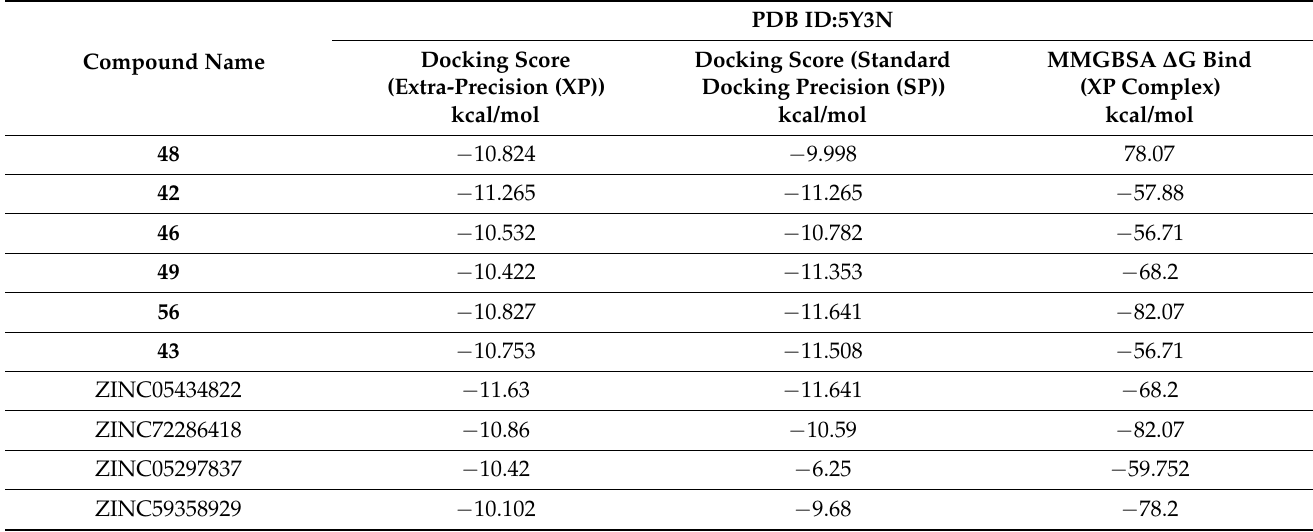
Table 6. Docking scores of active compounds and ZINC screened compounds with their MMGBSA